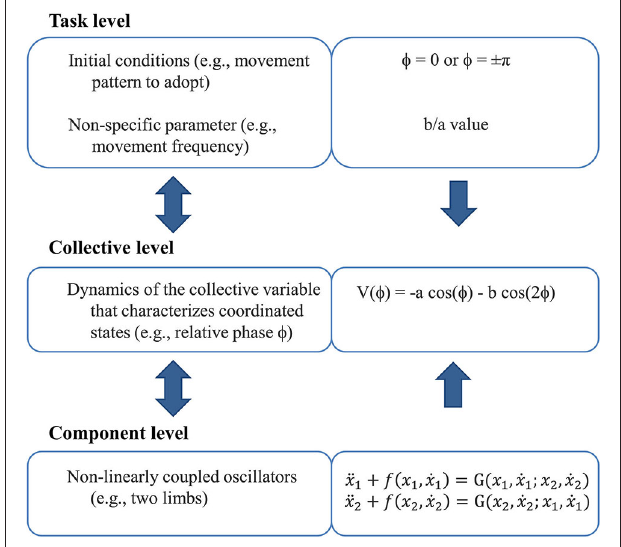
FIGURE 2 | The tripartite scheme (inspired from Kelso, 1995) . It links the three phenomenological levels of description from the perspective of dynamic pattern